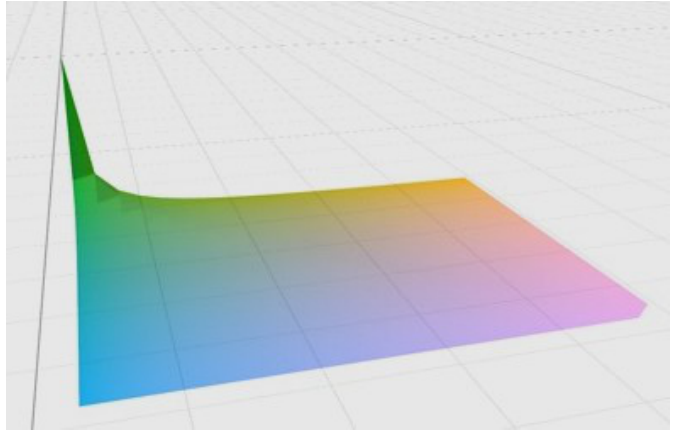
Figure 19. Anger + Fear—agreeableness